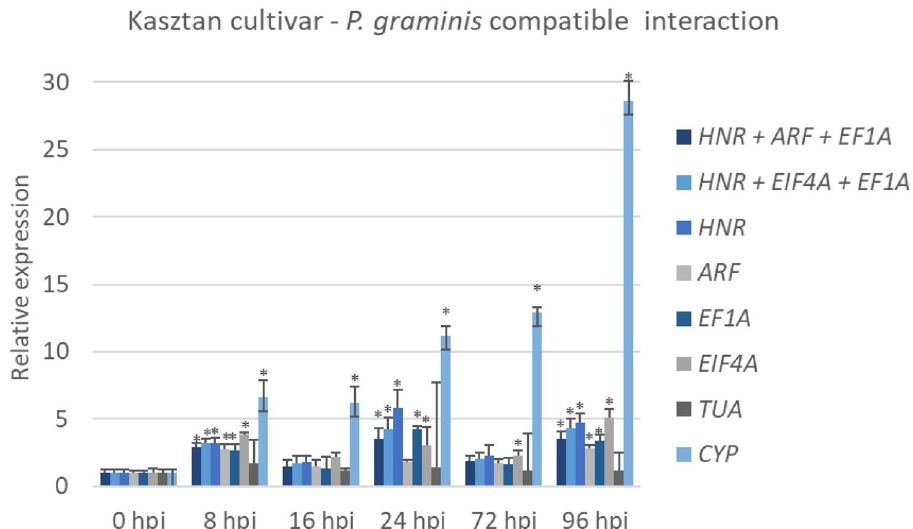
Figure 2. Relative expression of the PAL gene in A . sativa Kasztan cultivar– P. graminis compatible interaction. Analysis was performed against two sets of best performing RGs ( HNR + ARF + EF1A and HNR + EIF4A + EF1A ) separately or together as well as against worst performing RGs ( CYP and TUA ). Data are shown as mean ± SD. * indicate that the difference in expression between untreated (0 h) and inoculated data subgroups is significant at P ≤ 0.05 as determined by Student’s t